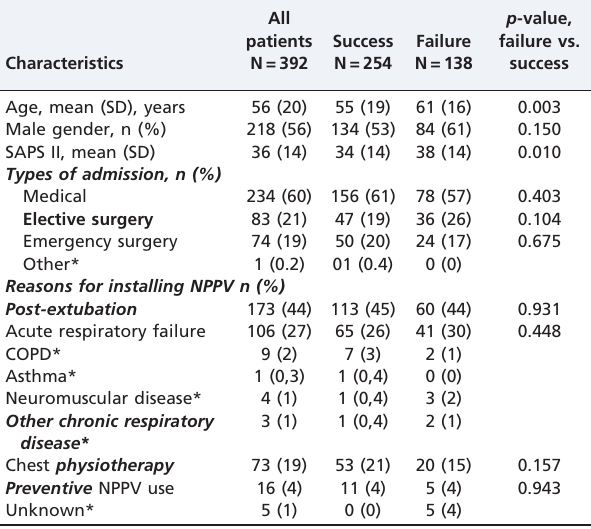
Table 1 - Baseline characteristics of the study group according to the outcome of noninvasive positive- pressure ventilation.